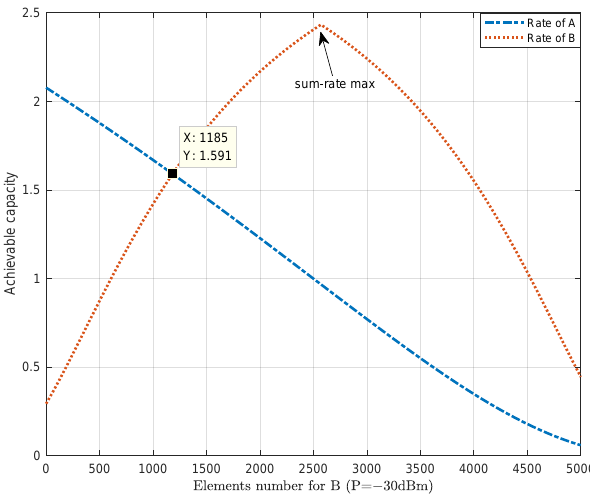
Figure 2. Achievable rate versus the reflecting elements